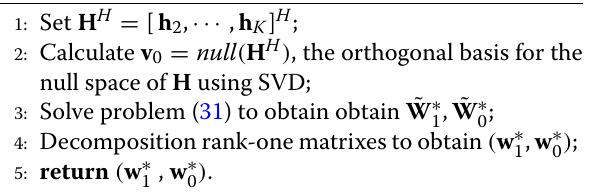
Algorithm 2 The ZF-based suboptimal algorithm to (12)